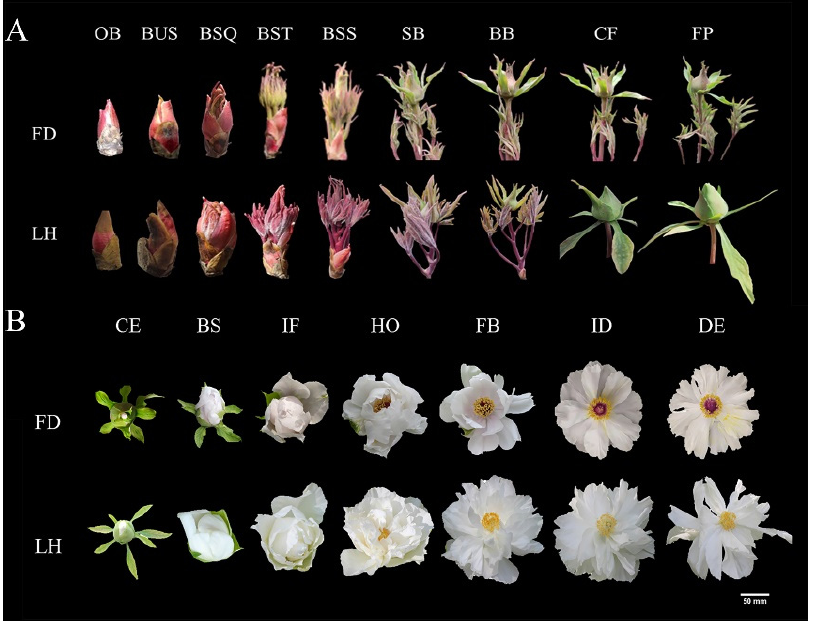
Figure 1. Typical features of two tree peony varieties during bud development process ( A ) and flower development stages ( B ). FD: Paeonia ostii ‘Feng dan’; LH: Paeonia suffruticosa ‘Lian he’; OB: Overwintering bud; BUS: Budding stage; BSQ: Bud-squaring stage; BST: Bud-sticking stage; BSS: Bud-standing stage; SB: Small-bell stage; BB: Big-bell stage; CP: Circular peach stage; FP: Flat peach stage; CE: Color-exposure stage; BS: Blooming stage; IF: Initial flowering stage; HO: Half opening stage; FB: Full blooming stage; ID: Initial decay stage; DE: Decay stage.